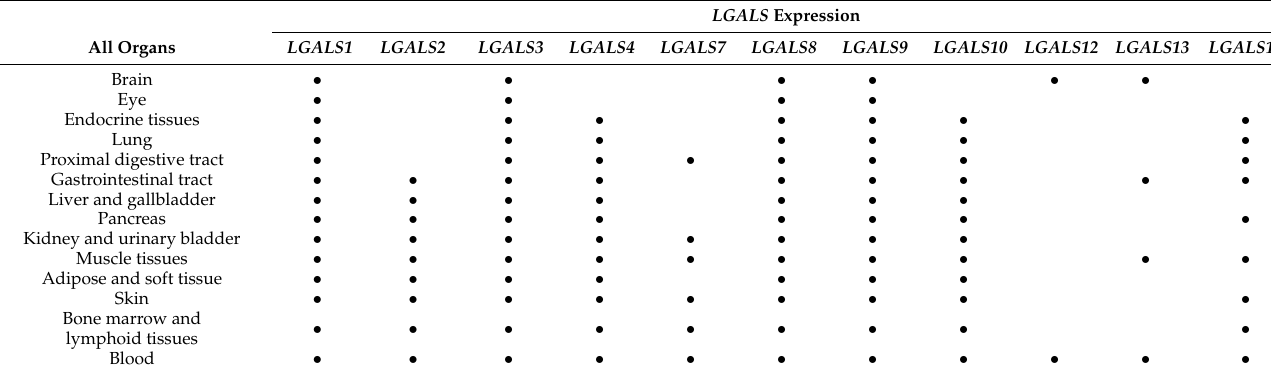
Table 1. Relative RNA expression of galectin ( LGALS ) in organs.